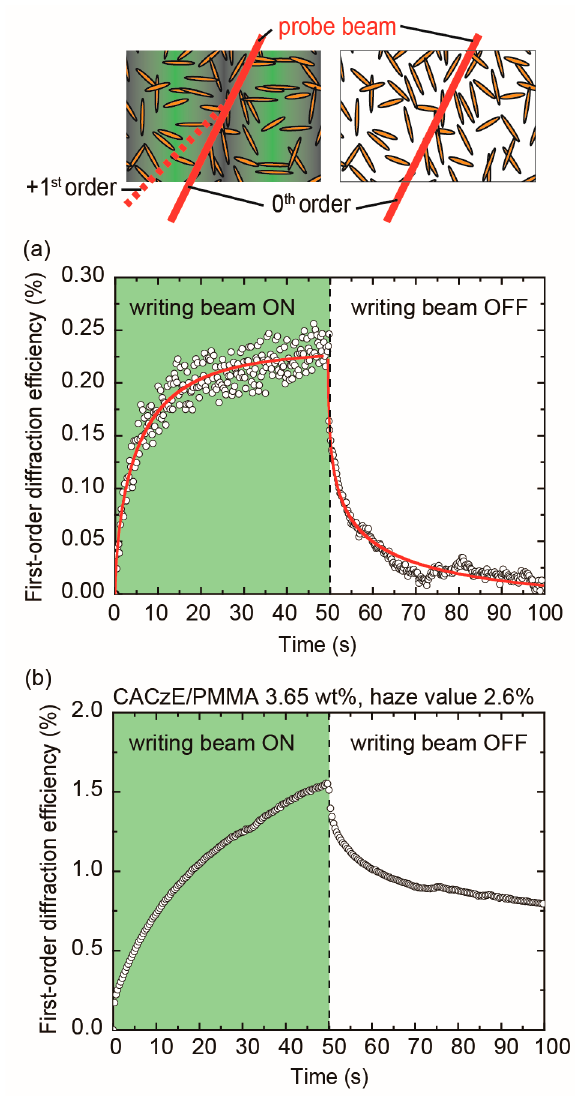
Figure 6. Top-view schematic representation of diffraction responses of probe beam for perpendicular orientation (left) and random orientation (right) of the CACzE dyes. ( a ) Time evolution of the first-order diffraction efficiency for the dye-doped UP resin film with 3.65 wt.% (Entry 10, immersion time 12 h). ( b ) Time evolution of the first-order diffraction efficiency for the melt-press CACzE/PMMA with 3.65 wt.%.